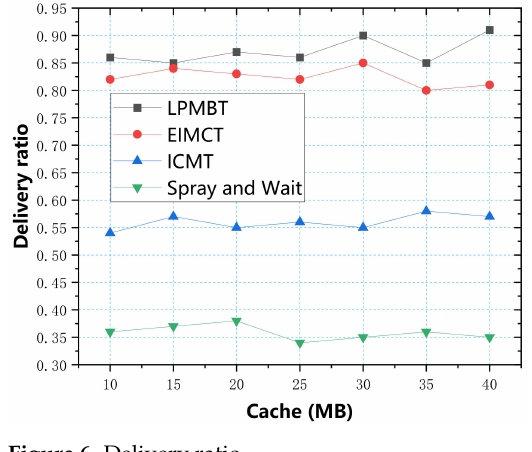
Figure 6. Delivery ratio.